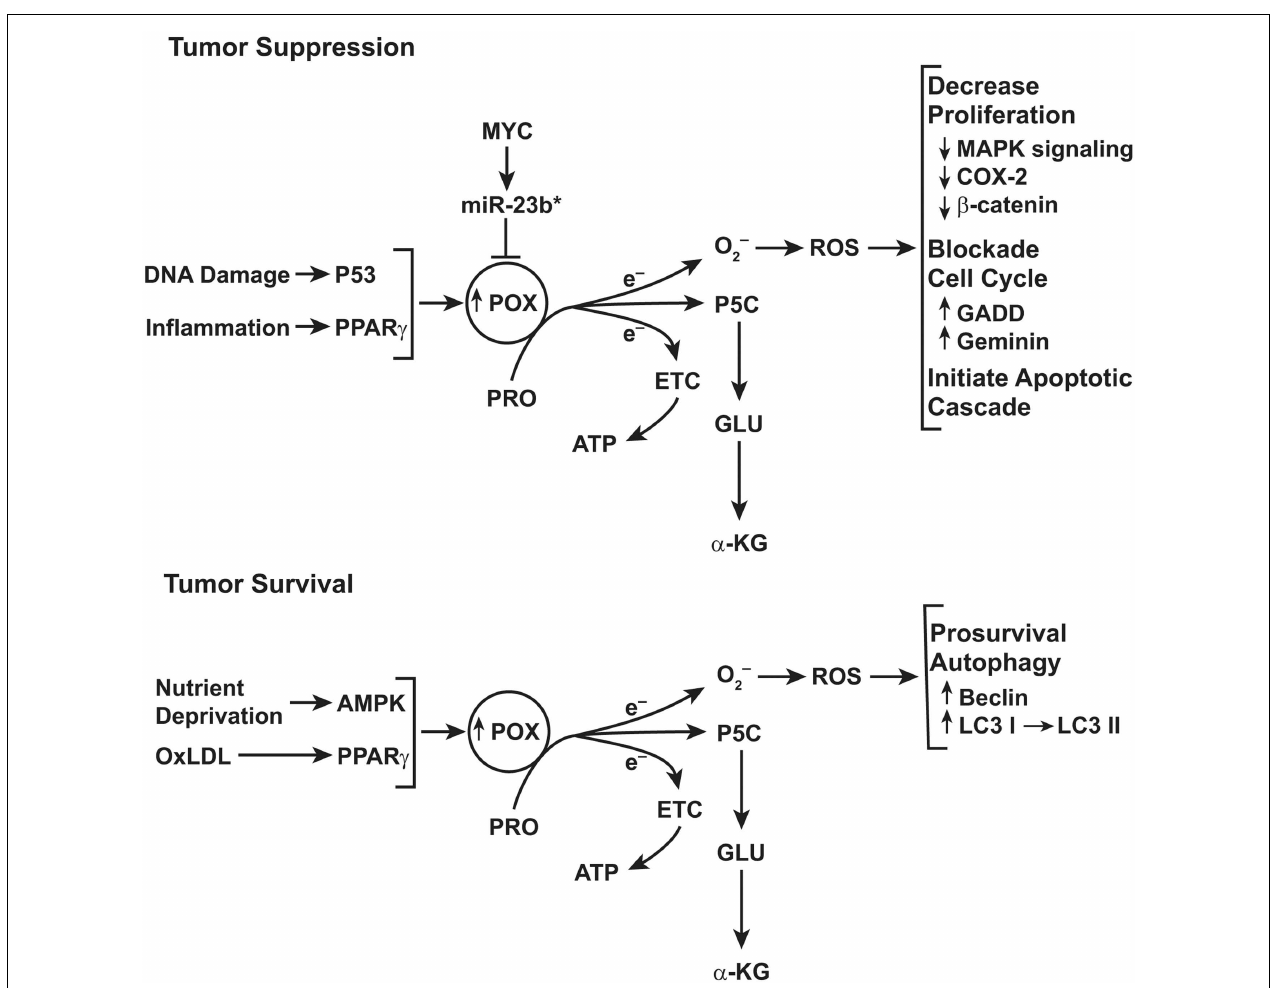
under conditions of metabolic stress.The functions of POX depend on metabolic context. Under conditions of glucose or oxygen deprivation or when treated with oxidized LDL, PPAR γ , POX expression is upregulated. The proline-dependent ROS generated by POX activate prosurvival autophagy mediated by conversion of LC3 I to LC3 II and by expression of